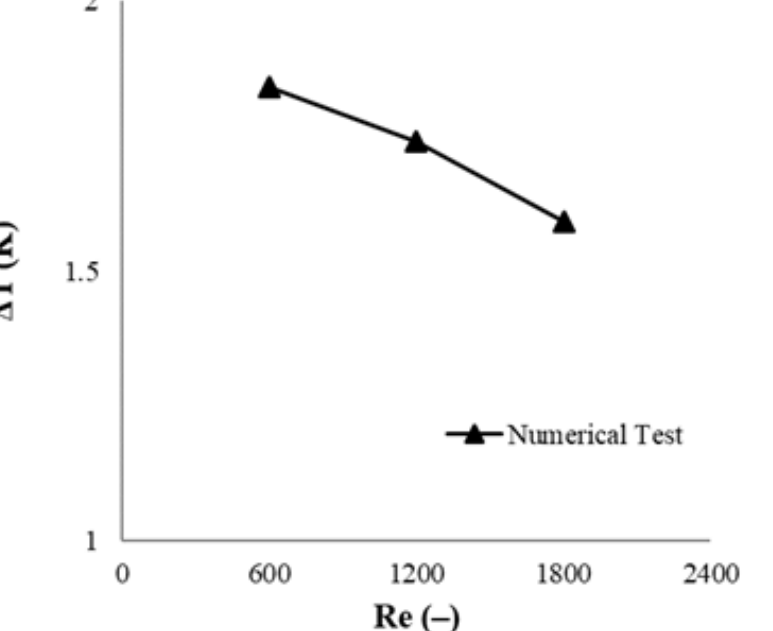
Figure 6. Comparison of maximum temperatures (K) obtained by changing Reynolds numbers (pure water).